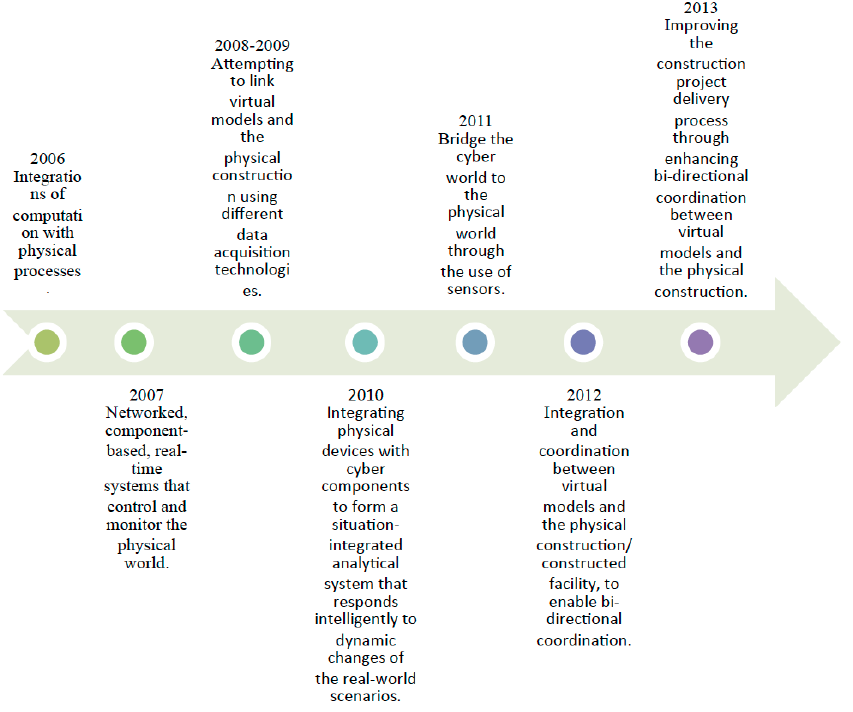
Fig. 3. A timeline for the evolution of the Cyber Physical Systems (Source: Authors, based